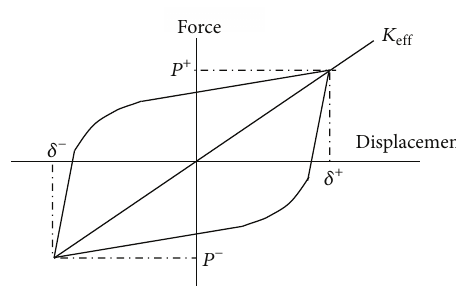
Figure 15: Definition of effective stiffness.